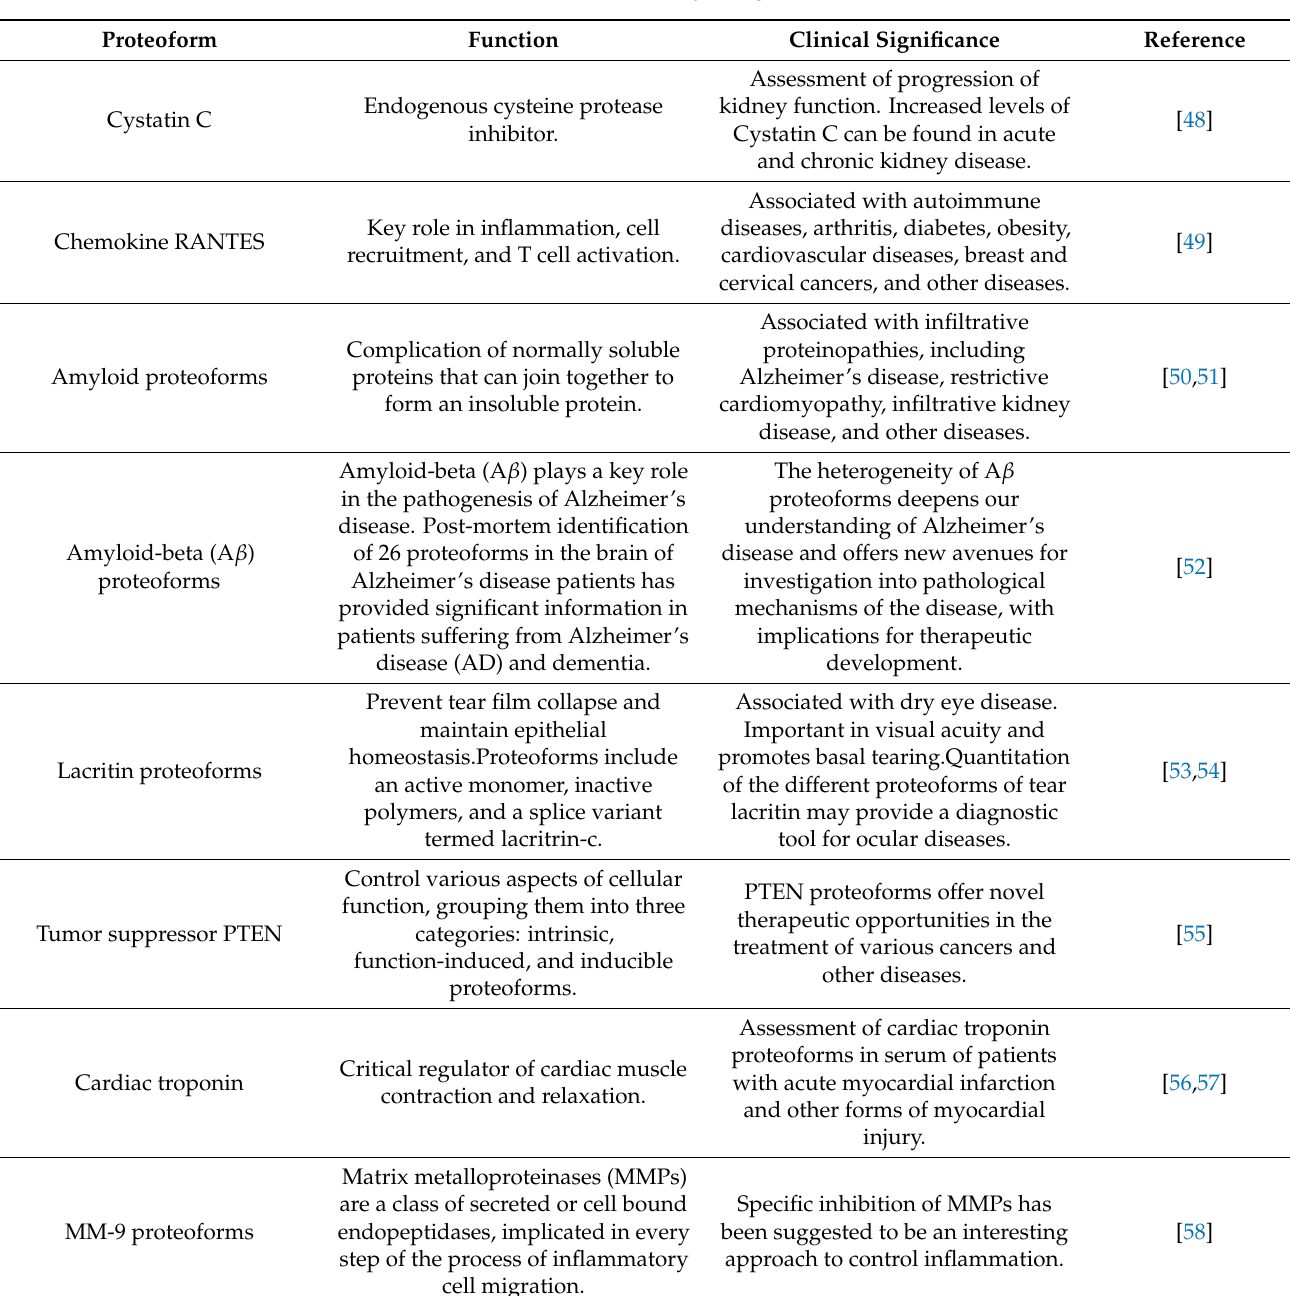
Table 1. Association of Proteoforms with Physiological Functions and